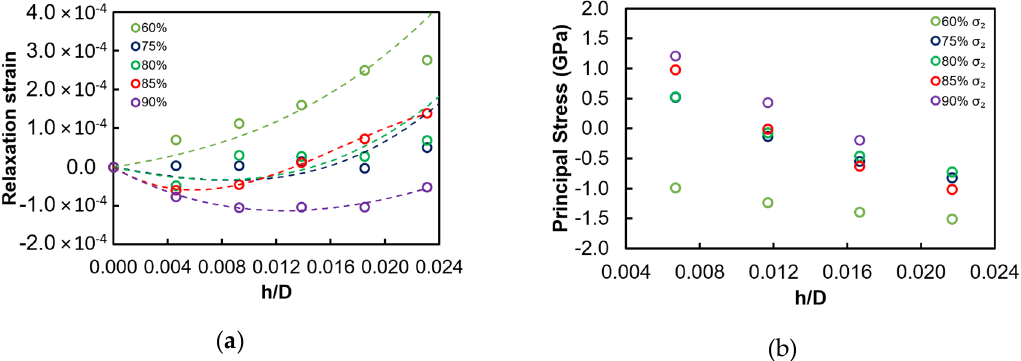
Figure 9. Analysis of the surface residual stress gradient for the sample after heat treatment. ( a ) Figure 9. Relaxation strain (with fitting of polynomial function, grade 4) along three directions before Experimental relaxation strain (along one direction, as an example, where dashed lines represent the heat treatment (examples for radius% = 80%) ( a ) and after heat treatment ( b ). Principal residual stress polynomial interpolation) for different values of radius% ; ( b ) Corresponding residual stress profiles profiles ( σ 1 and σ 2) obtained by considering multiple radius% , ( c ) before the heat treatment cycle and (second principal stress, as an example). ( d ) after the heat treatment cycle. (Dashed lines indicate the di ff erent layers of the films, according to the architecture described in Section